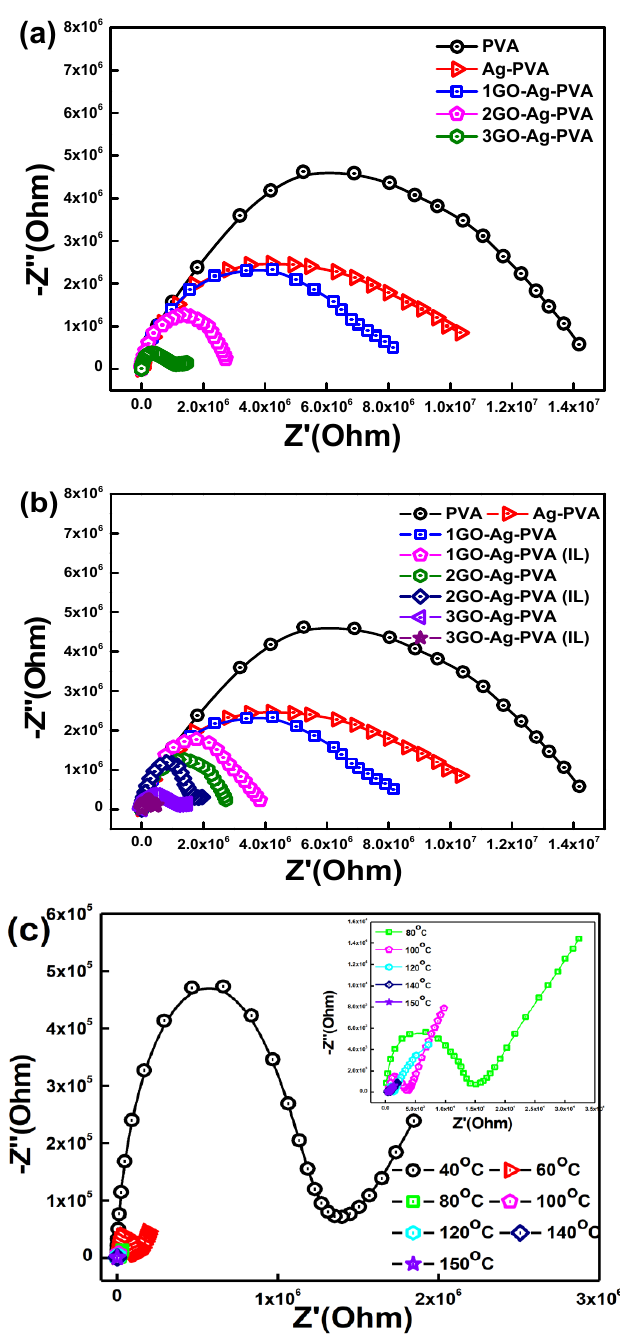
Figure 7. Nyquist plot of GO-Ag-PVA nanocomposites as a function of ( a ) GO loading, ( b ) ionic liquid and ( c ) temperature effect on 3GO-Ag-PVA (IL). The inset shows magnified image of (c)